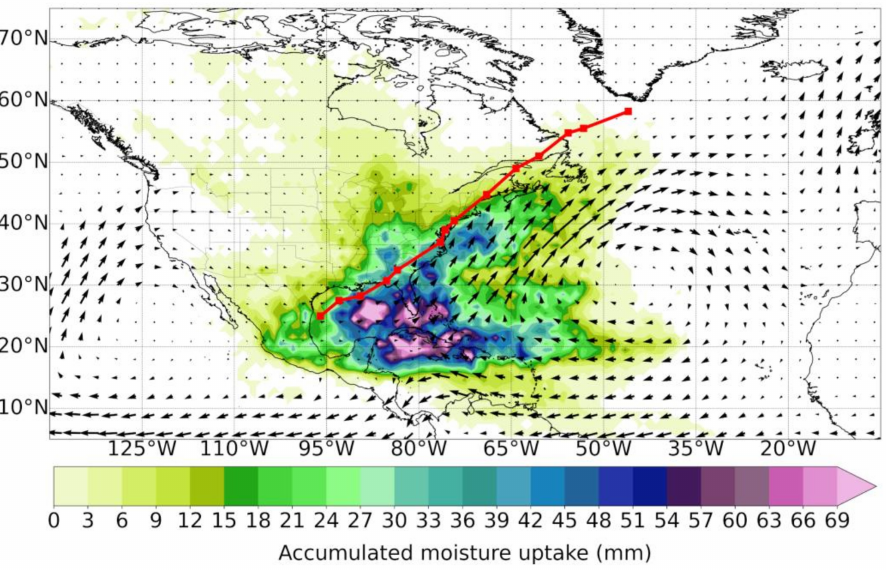
Figure 6. Accumulated moisture uptake (mm) during the SC93 lifetime. The vertically integrated moisture flux is represented by arrows (kg/ms). The red line denotes the SC93 trajectory, while the centre of SC93 every 6 h is marked with a filled